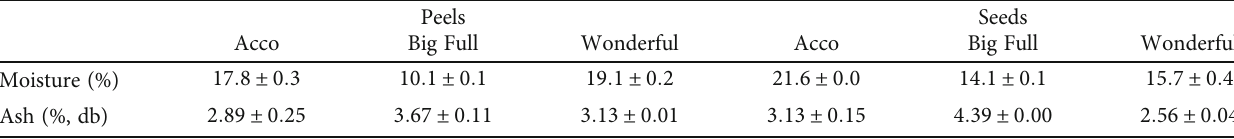
Table 1: Characterization of Acco, Big Full, and Wonderful peels and seeds.